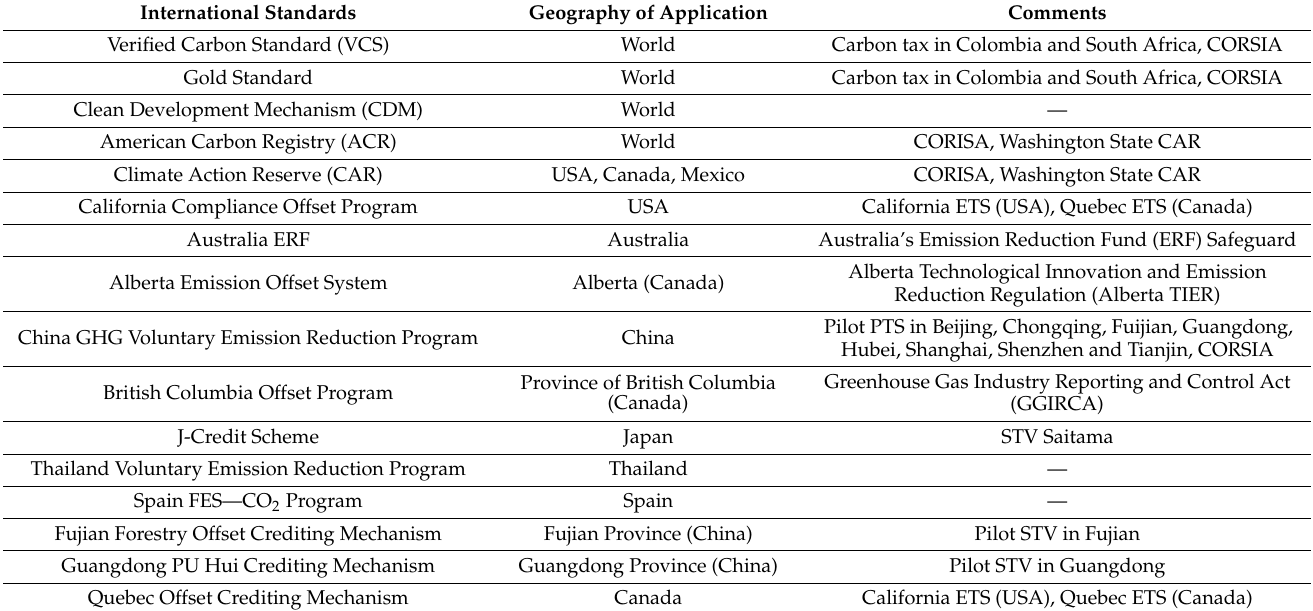
Table 7. Types of international